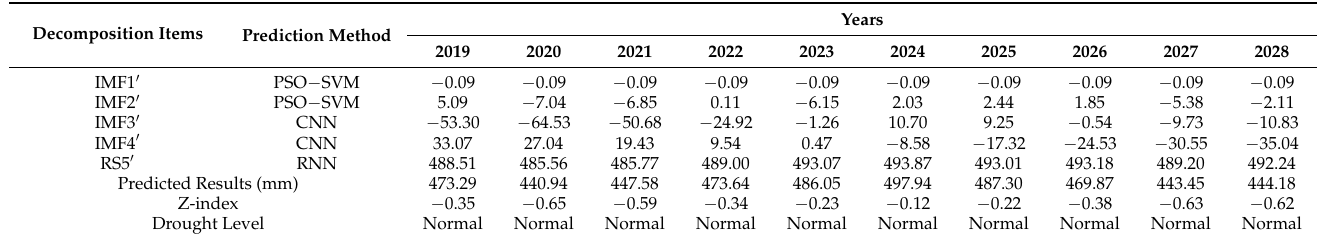
Table 3. Precipitation forecast and drought assessment for the summer of 2019–2028 in the Wujiang River